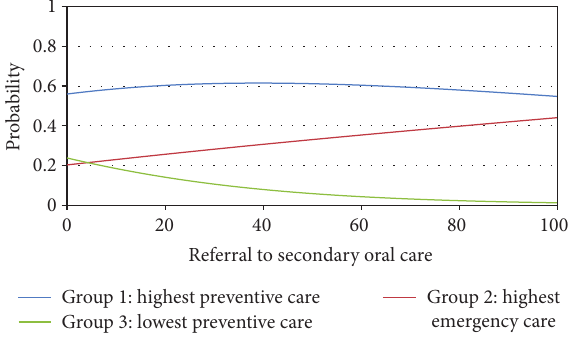
Figure 2: Probability of pertaining to each cluster according to referral to secondary oral care in Belo Horizonte, Brazil,